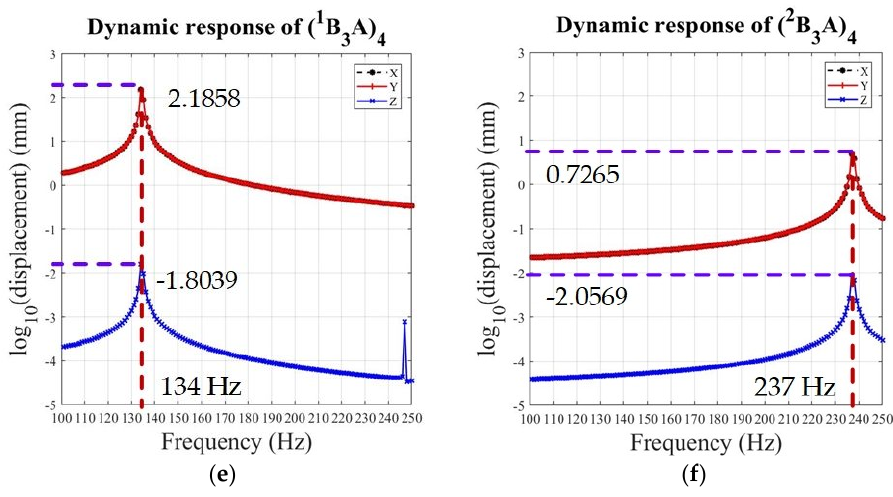
Figure 14. Comparation of dynamic response of end-effort structure of MPS: ( a – f ) along the X , Y , and Z axes about Mon-str, (B 3 A) 4 -AL, (B 3 A) 4 -45, (B 3 A) 4 -PLA, ( 1 B 3 A) 4 , and ( 2 B 3 A) 4 , respectively. Table 4. The natural frequency of different decoupled parallel XY MPSs.